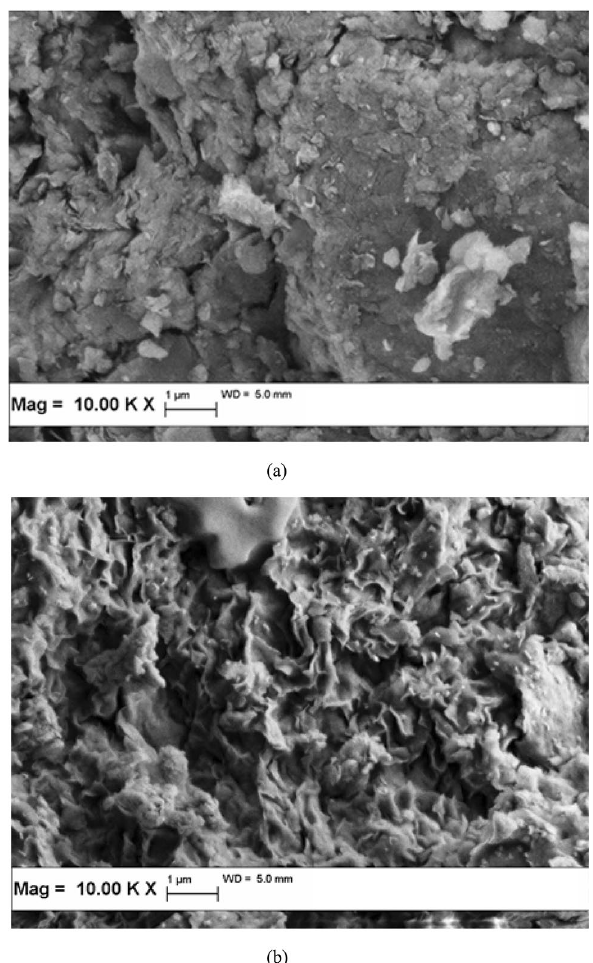
Figure 5. Scanning electron micrographs of ( a ) bentonite and ( b )